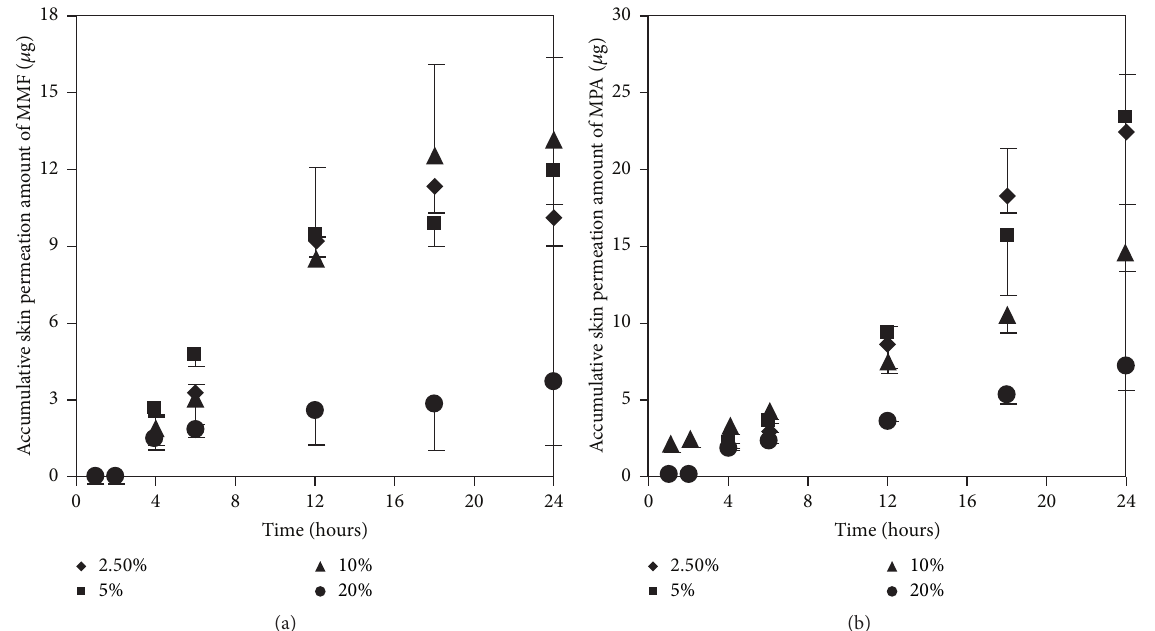
Figure 5: Skin permeation profiles of MMF (a) and MPA (b) at various concentrations of EUL (2.5, 5, 10, and 20 w/v) incorporated to 300 𝜇 g/mL of MMF preparation.